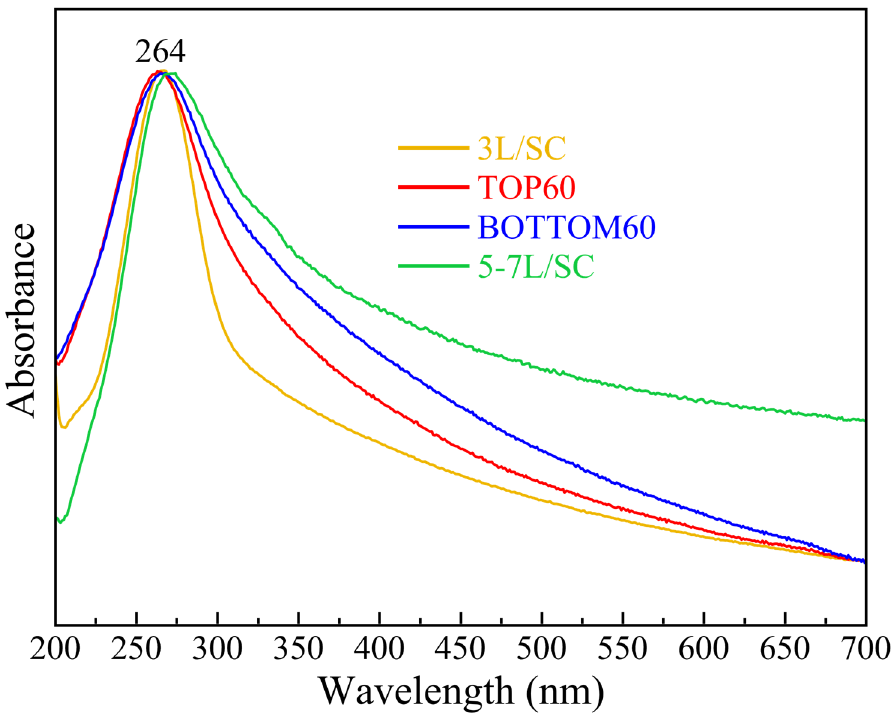
Figure 5. Comparison among normalized UV ‐ vis absorption/extinction spectra of water dispersions containing commercial graphene nano ‐ sheets (3L/SC, 5 ‐ 7L/SC) and TOP60, BOTTOM60 GNPs.